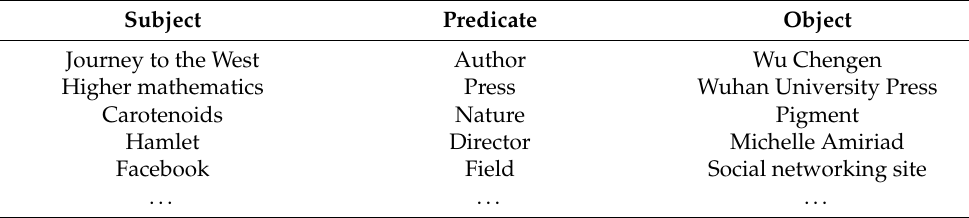
Table 1. Triads in the Knowledge